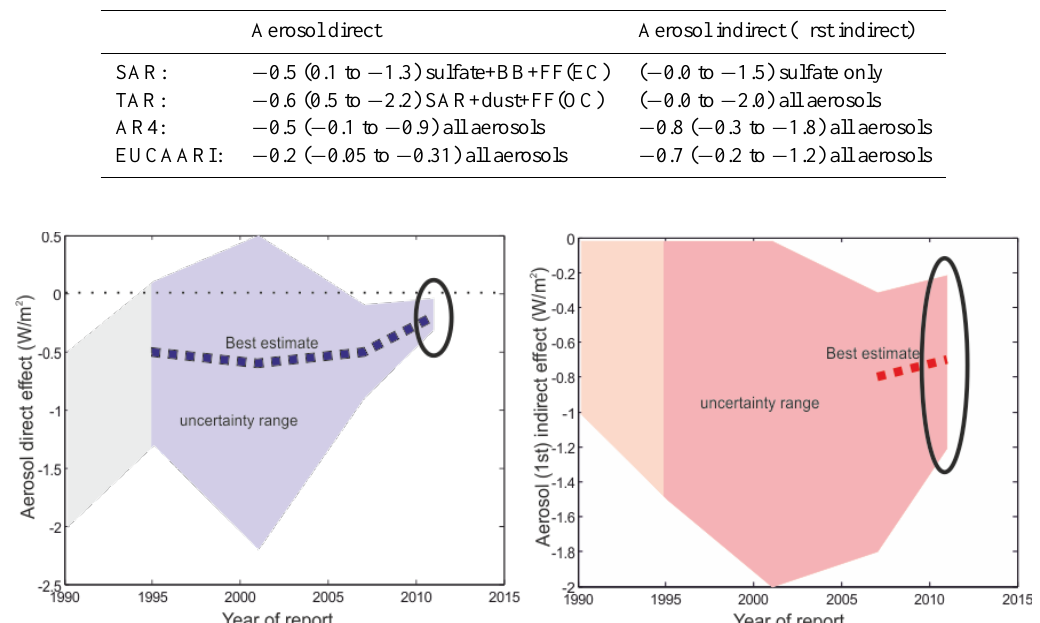
Table 4. Aerosol forcing according to different IPCC reports: Forcing (Wm 2 ), BB=Biomass Burning aerosols, FF=Fossil Fuel burning aerosols.